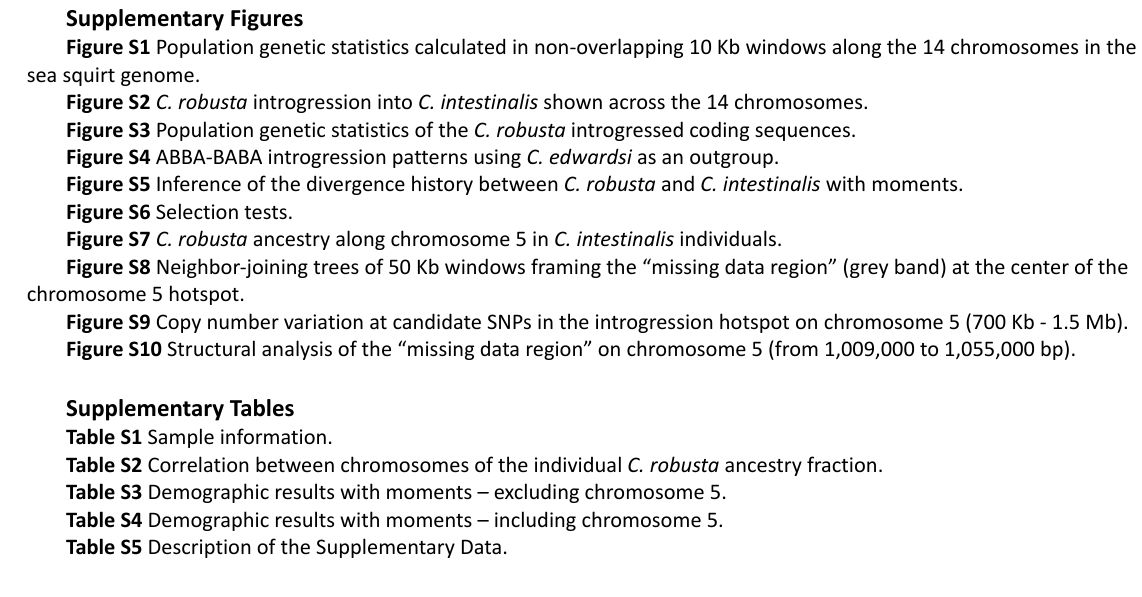
Figure S2 C. robusta introgression into C. intestinalis shown across the 14 chromosomes. Figure S3 Population genetic statistics of the C. robusta introgressed coding sequences. Figure S4 ABBA-BABA introgression patterns using C. edwardsi as an outgroup. Figure S5 Inference of the divergence history between C. robusta and C. intestinalis with moments. Figure S6 Selection tests. Figure S7 C. robusta ancestry along chromosome 5 in C. intestinalis individuals. Figure S8 Neighbor-joining trees of 50 Kb windows framing the “missing data region” (grey band) at the center of the chromosome 5 hotspot.